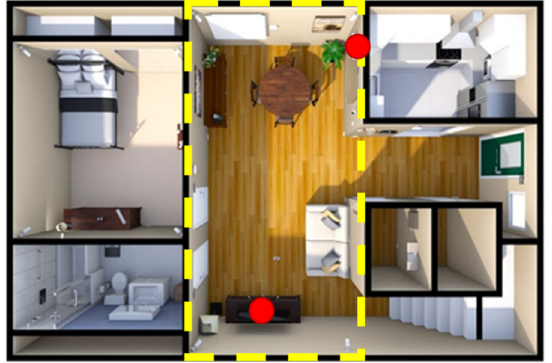
Figure 1. HomeLab layout at KITE Research Institute, where the yellow box represents the areas in the field of view of the cameras, and the red represents the location of the cameras. Table 1. List of all activities performed in our